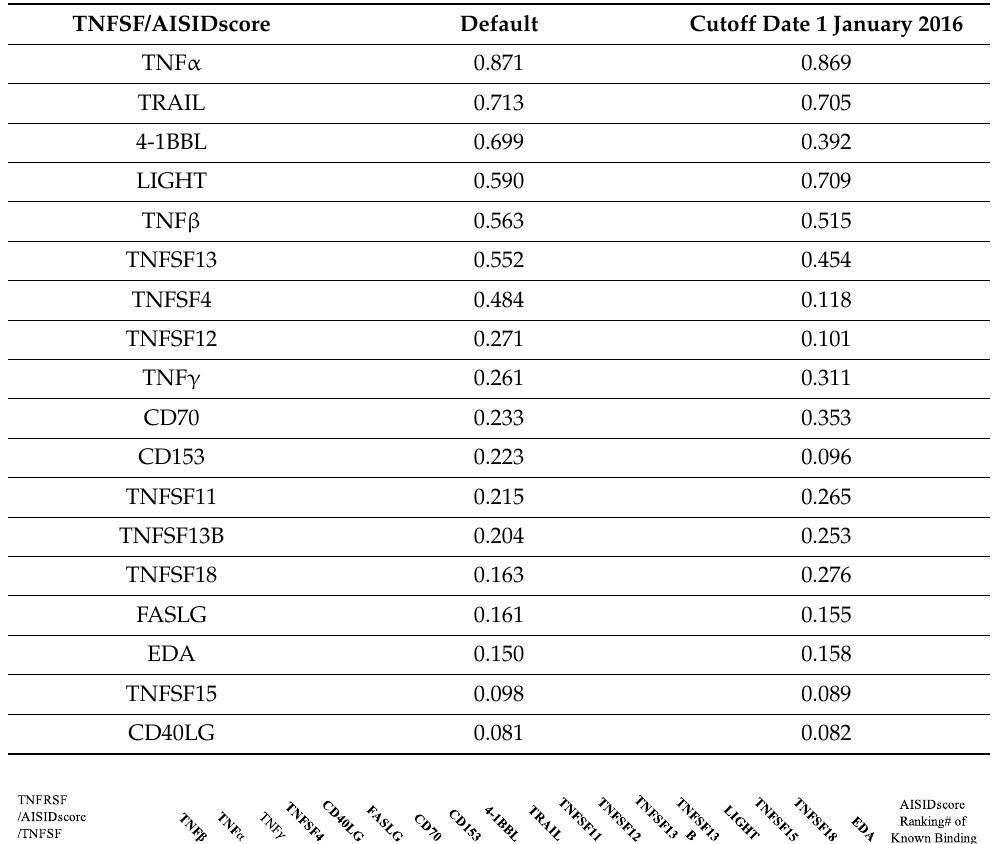
Table 1. AISIDscores of TNF α nanobody against TNFSF superfamily.